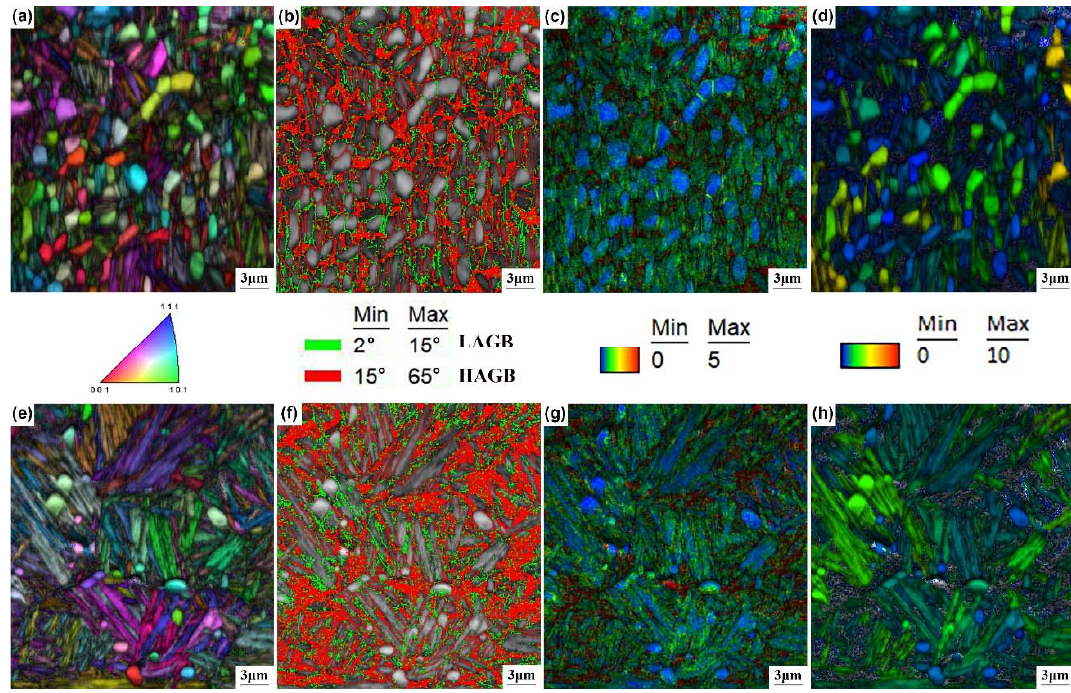
Figure 5. ( a , e ) IQ + IPF, ( b , f ) grain boundary distribution, ( c , g ) IQ + KAM and ( d , h ) IQ + GOS diagrams of the test steel austempered above Ms after intercritical annealing at 760 °C and 770 °C. The XRD patterns of the test steel following different heat treatment processes are shown in Figure 6. BCC (ferrite) and FCC (austenite) phases were detected in all the sam- ples. The corresponding constituents of retained austenite as calculated by the XRD dif- fraction peak are summarized in Table 1. When the intercritical annealing temperature